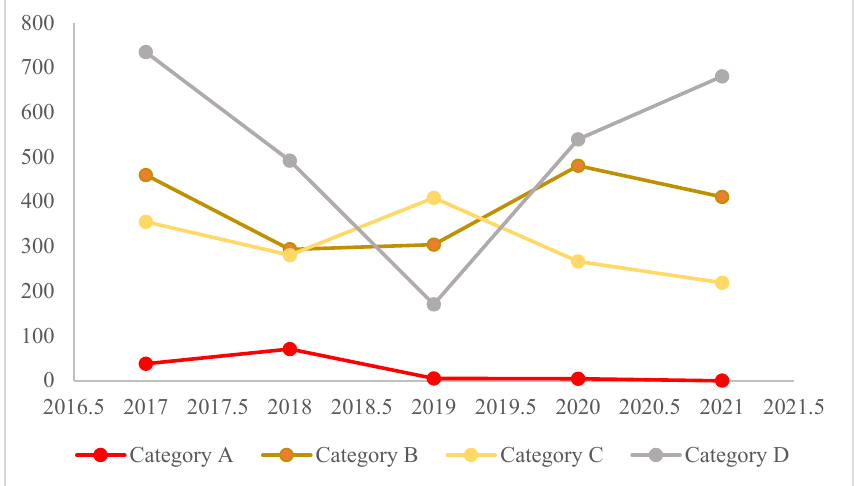
Figure 5. Progression of the resistance in the four antibiotic categories according to Emma’s catego- risation of the 1335 isolates between 2017 and 2021.